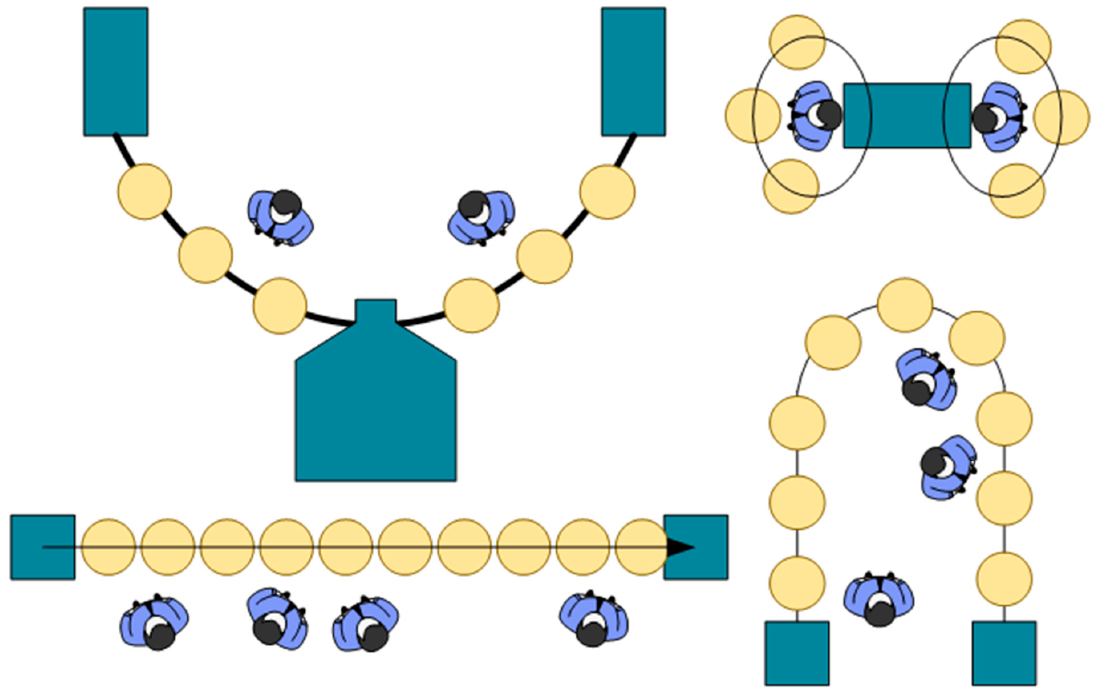
Figure 1. Typical production cell organization schemes.